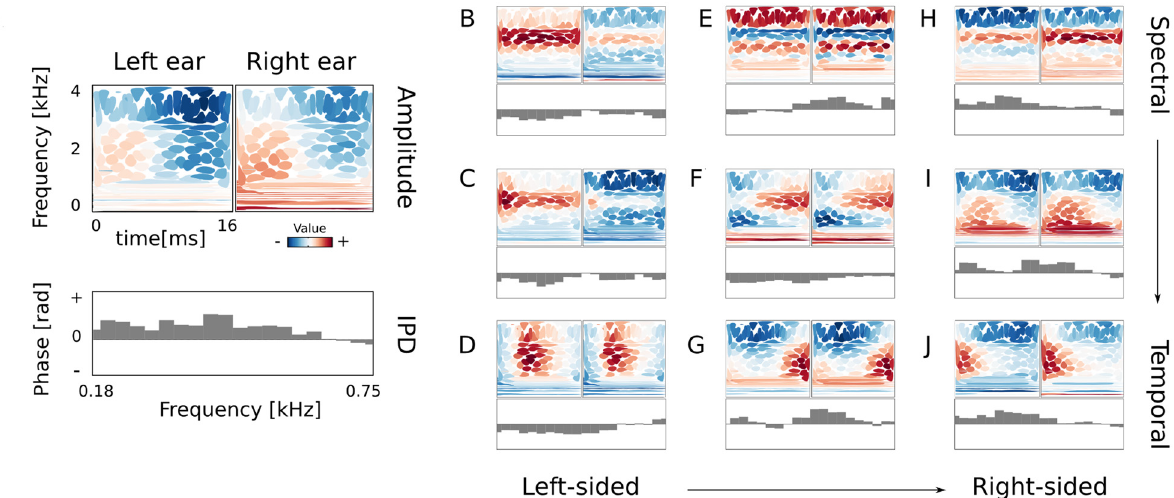
Fig 4. Higher-order basis functions. A) Explanation of the visualization of second layer basis functions. Top two panels depict the binaural amplitude basis function B i . Spectrotemporal information in each ear is represented using isoprobability contours of Wigner-Ville distributions of first-layer basis functions (see Fig 2). Colors correspond to the log-amplitude weight. The bottom panel represents the IPD basis function ξ i . Each gray bar represents one of 20 selected low-layer basis functions. Here almost all values are positive (the bars point upwards), which corresponds to the right-ear precedence. B)-J) Basis functions ordered vertically by spectral modulation and horizontally by the dominating